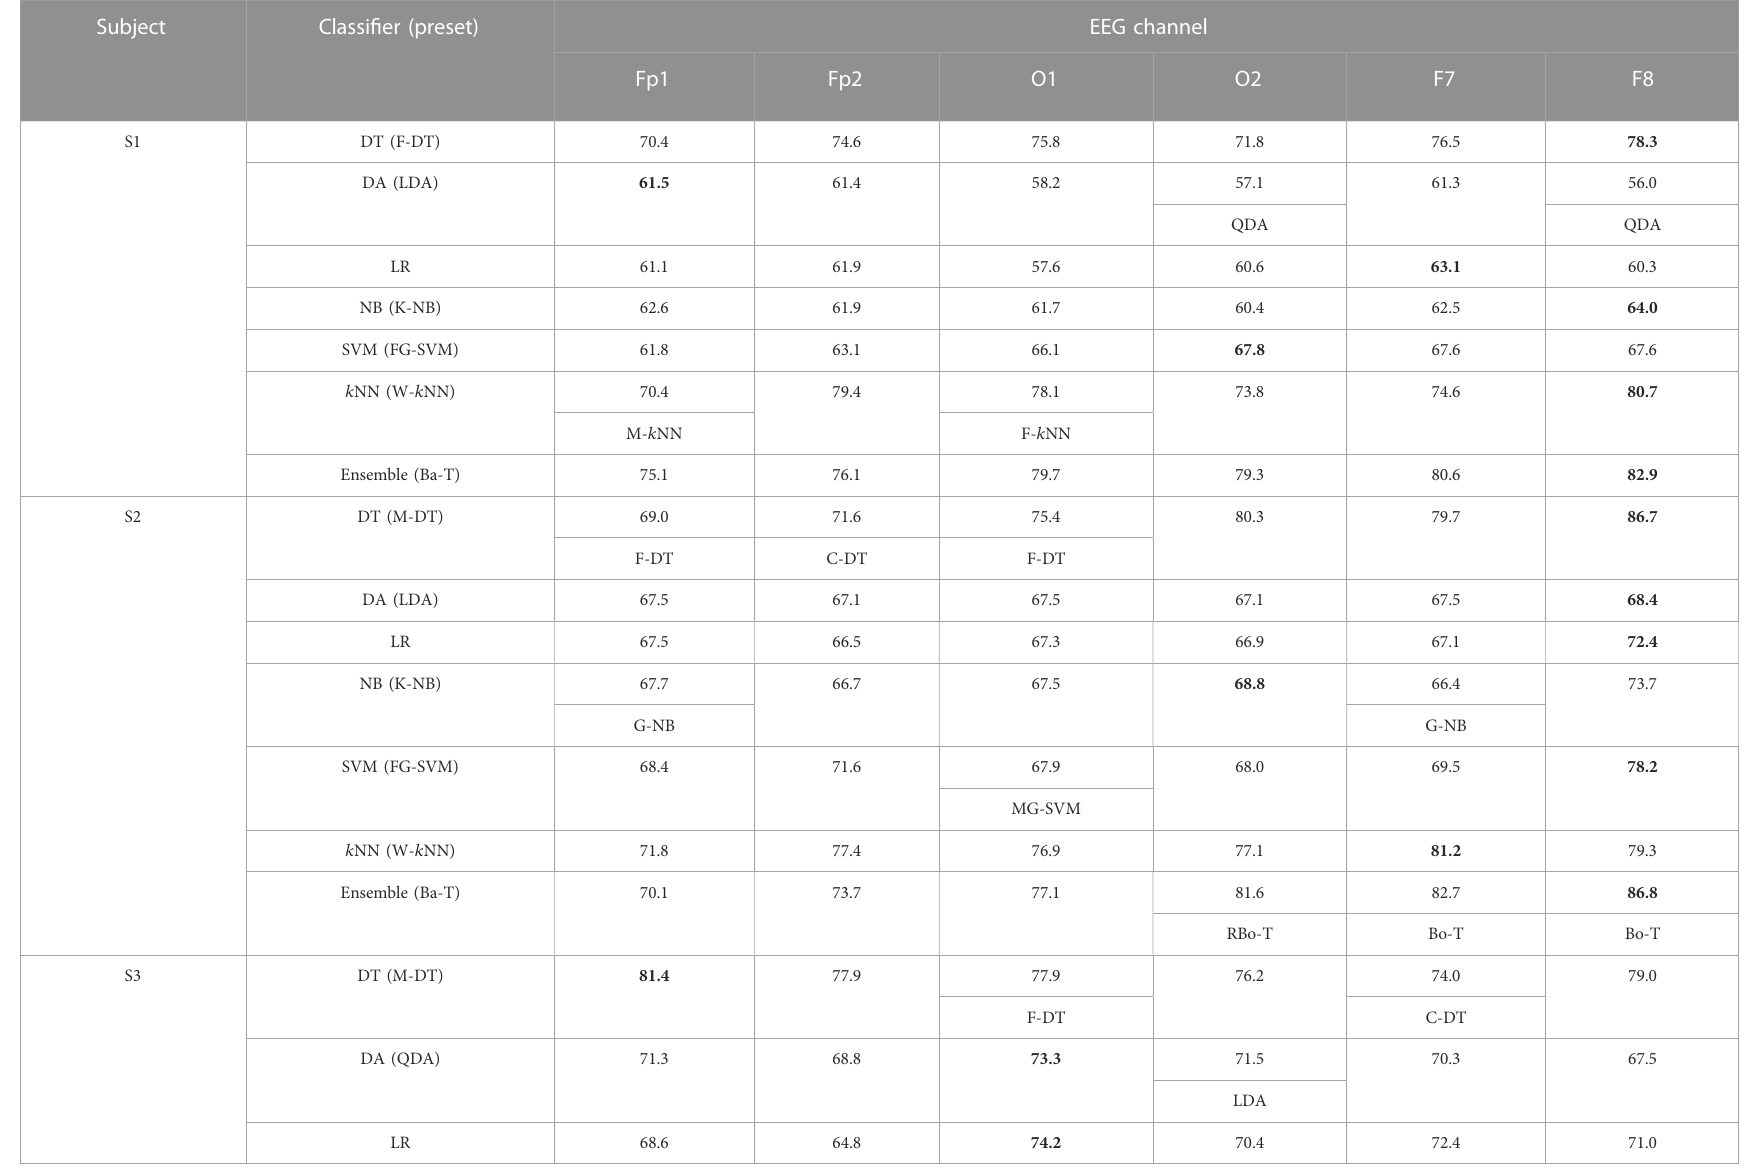
TABLE 1 Average classi fi cation accuracies (%) obtained with all spectral features, for all channels, and all the classi fi ers with best-performing presets (subjects 1 –